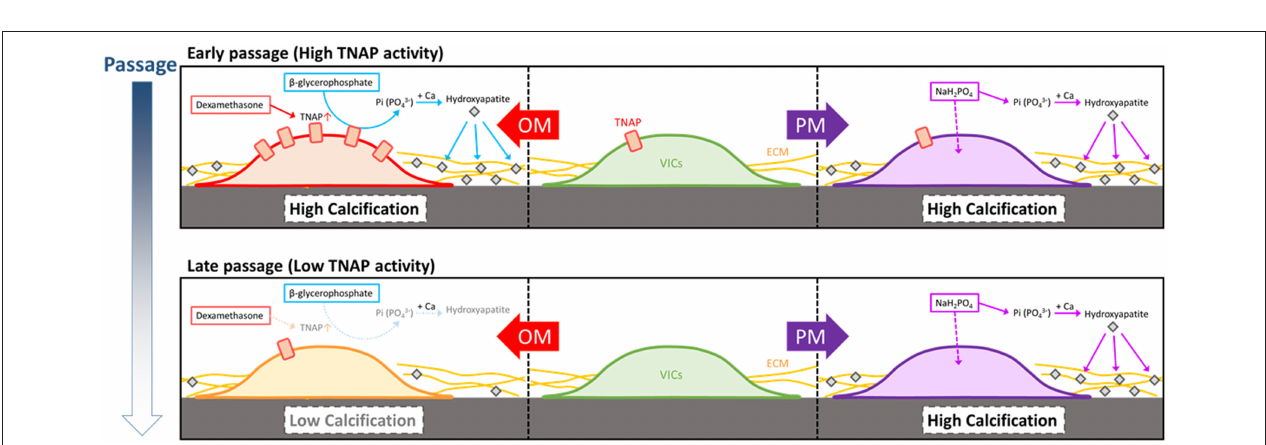
FIGURE 9 | Model of OM and PM induction of VIC calcification, including passage-dependent effects. At early passage, some but not all VICs isolated from human calcific aortic valve disease donor tissues can have relatively high tissue non-specific alkaline phosphatase activity (TNAP), which is reduced by culture passaging. TNAP hydrolyzes β -glycerophosphate to inorganic phosphate that is incorporated into nascent hydroxyapatite crystals forming cardiovascular calcifications along with reducing the calcification inhibitor, pyrophosphate, making OM VIC calcification donor- and TNAP-dependent. Pro-calcifying media containing inorganic phosphate does not require TNAP to form hydroxyapatite crystals, and as such PM calcification is not suppressed by passage-dependent reductions in TNAP activity.